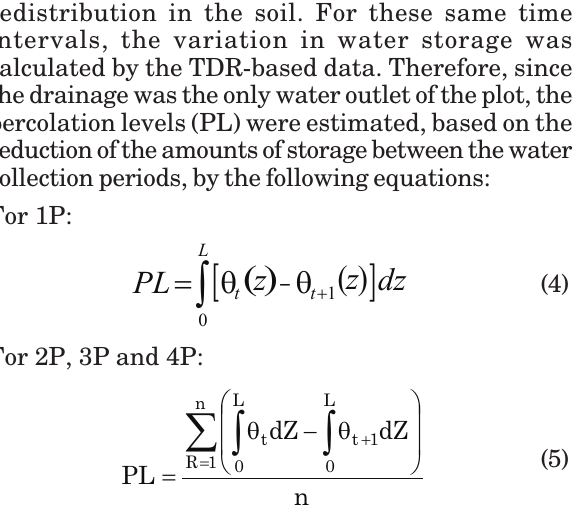
Table 1. Hydro-physical properties of the soils used to fill the lysimeters